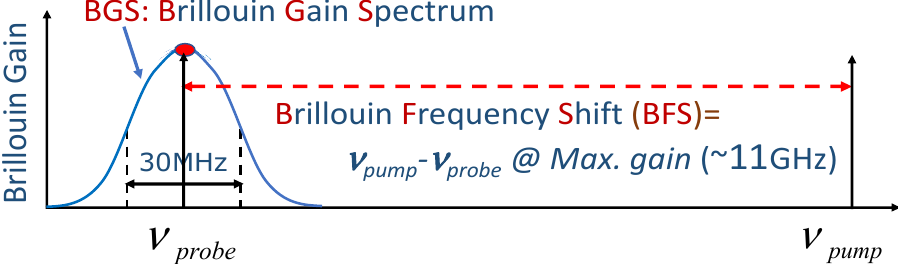
Figure 7. Brillouin amplification in single-mode fibers. Pump light at an arbitrary frequency/wavelength, e.g., λ B = 1550 nm, propagating in one direction in the fiber core generates narrowband gain for light propagating in the opposite direction. Gain is maximized when the frequency difference, υ pump − υ probe , equals the so-called Brillouin Frequency Shift, υ BFS . For silica-based single-mode fibers around 1550 nm, υ BFS is ~11 GHz and the Brillouin gain bandwidth is ~30 MHz for pulses longer than ~40 ns. Of crucial importance for sensing applications is the fact that υ BFS is a function of both strain and temperature, mainly through the dependence of the local acoustic velocity, V A , on these two